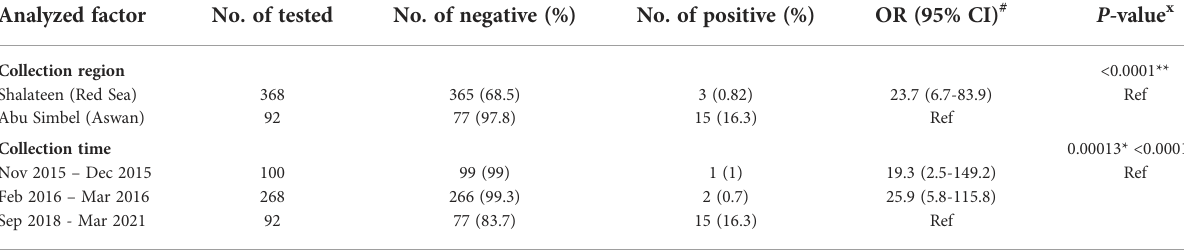
TABLE 3 Factors in fl uencing anti- Neospora caninum antibodies in camels in Egypt. Analyzed factor No. of tested No. of negative (%) No. of positive (%) OR (95% CI) # P- value x